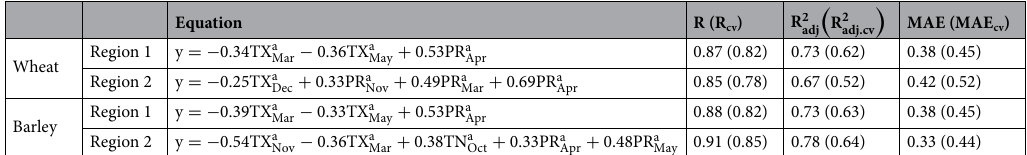
2 adj , and the mean